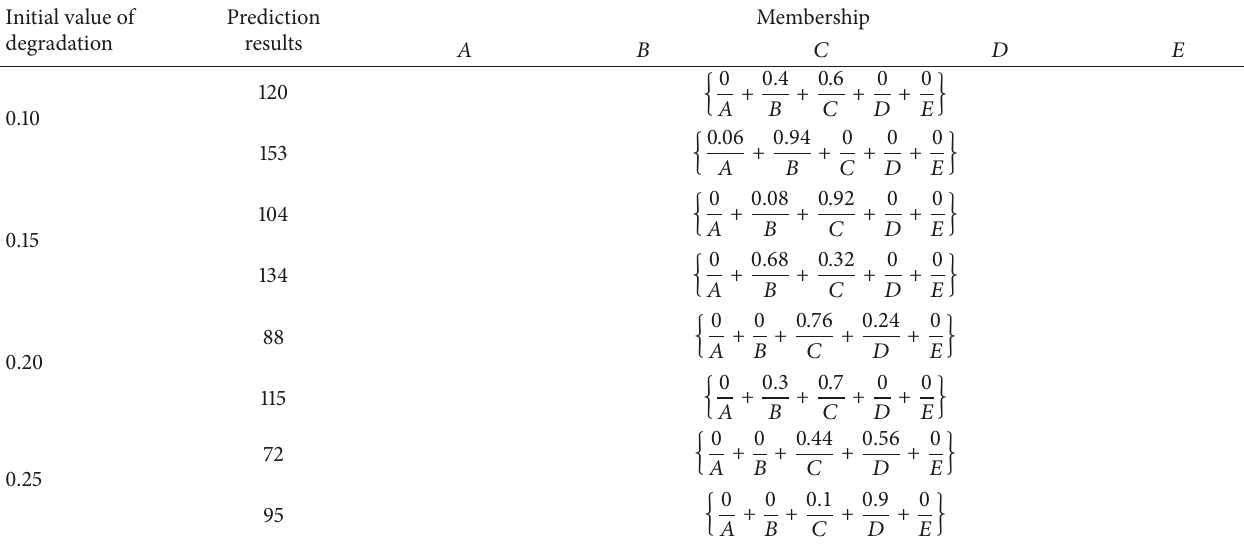
Table 9: The membership of 𝐾𝑜𝑥 and 𝐾𝑠𝑥 by fuzzy